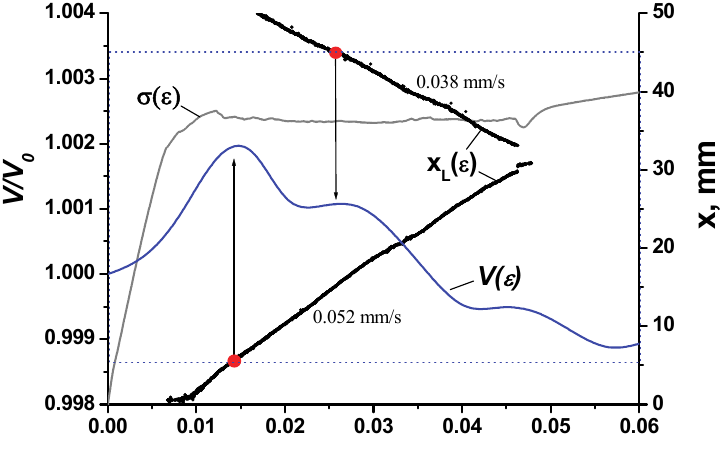
Figure 3: Propagation of the Luders band within the yield plateau in steel (G10080) and the change in the velocity of ultrasonic Rayleigh